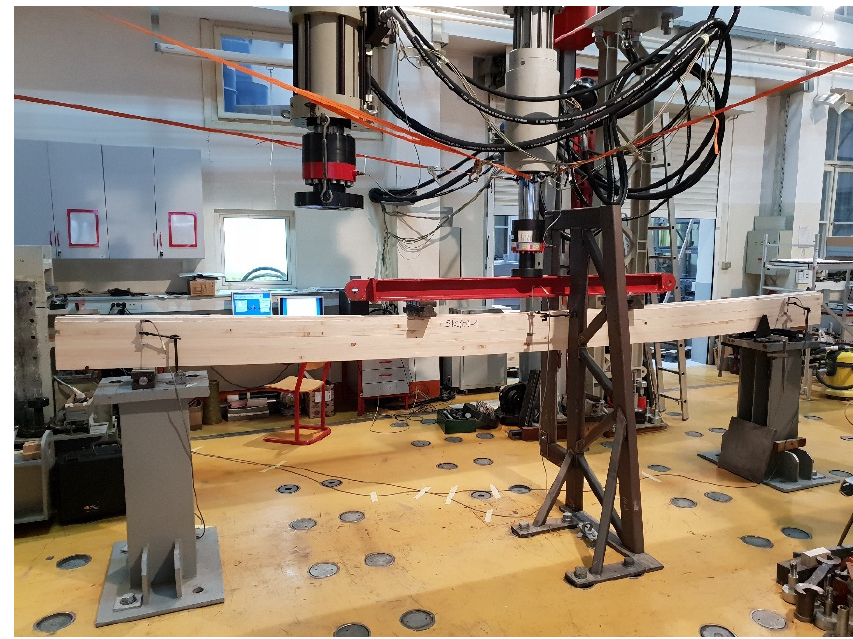
Figure 12. Timber beam during strong-axis bending experimental test.